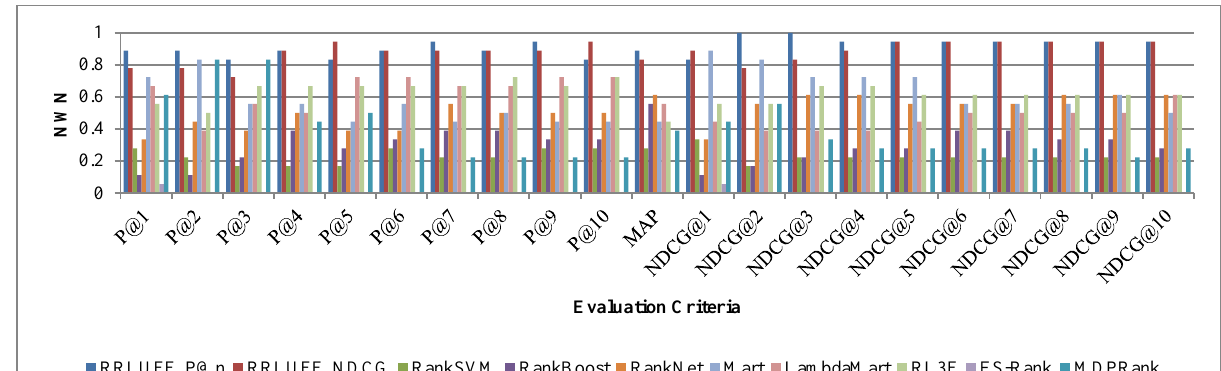
Figure 8. Comparison between the proposed algorithm and algorithms expressed regarding the evaluation criterion P@n on DOTIR Dataset.